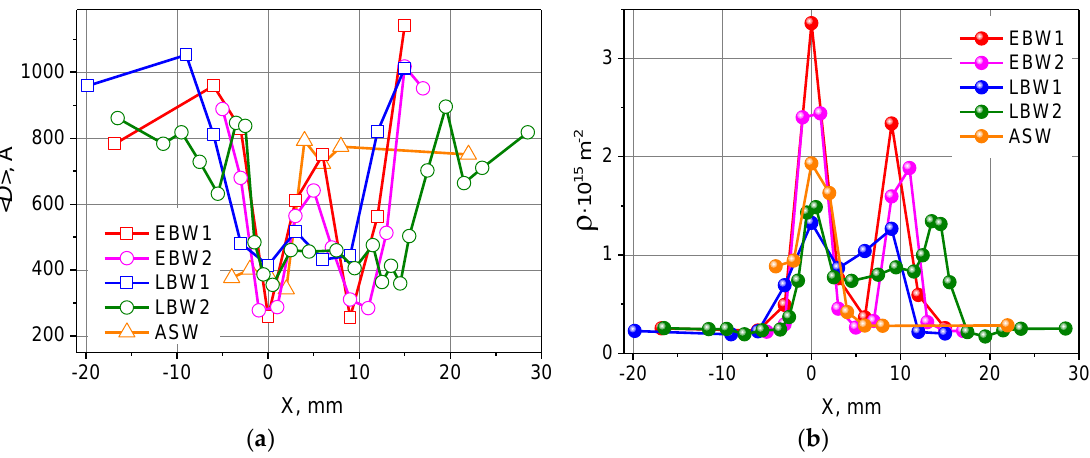
Figure 17. ( a ) Crystallite sizes 〈 D 〉 vs. scan coordinate X for all studied Charpy specimens. ( b ) vs. scan coordinate X for all studied Charpy specimens. Figure 17. ( a ) Crystallite sizes D (cid:104) (cid:105) Dislocation density distributions vs. scan coordinate X , adapted from [38], with permission from © ( b ) Dislocation density distributions vs. scan coordinate X , adapted from [38], with permission from © 2016 Springer. 2016